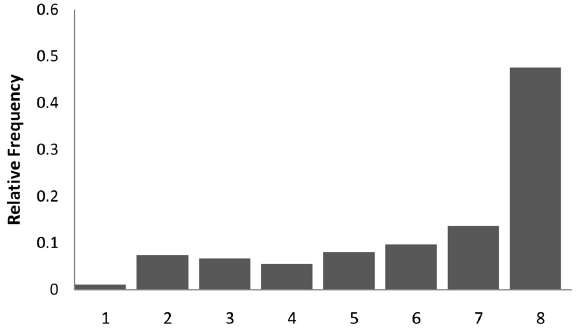
Fig. 6. Histogram of percentage of acceptable forecast of raw data and BMA outputs for ± 2 ◦ C error.